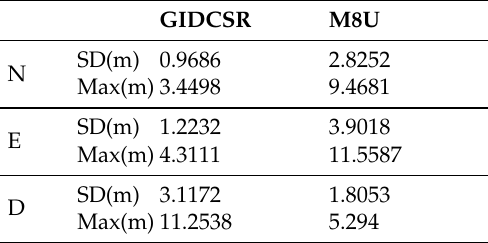
Table 6. Statistics of GNSS/INS integration